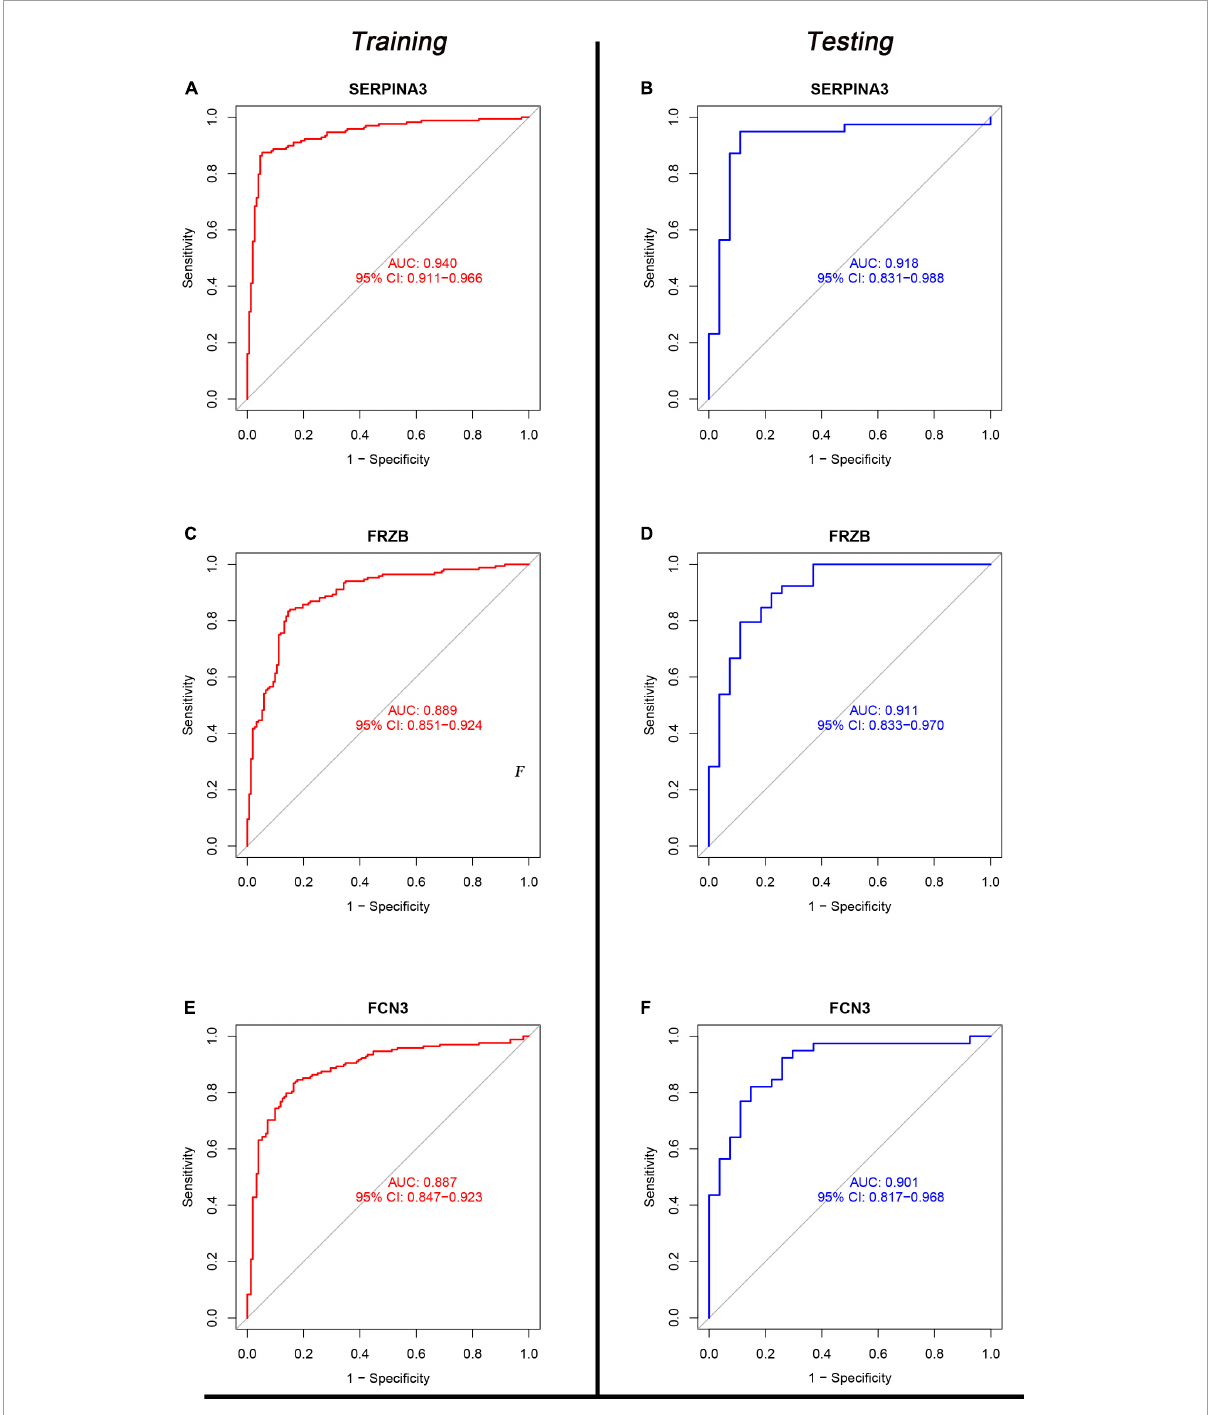
FIGURE6 The receiver operating characteristic (ROC) of SERPINA3, FRZB, and FCN3 between the control and dilated cardiomyopathy (DCM) groups. (A,C,E) The ROC of SERPINA3, FRZB, and FCN3 in the Training set; (B,D,F) the ROC of SERPINA3, FRZB, and FCN3 in the testing set.